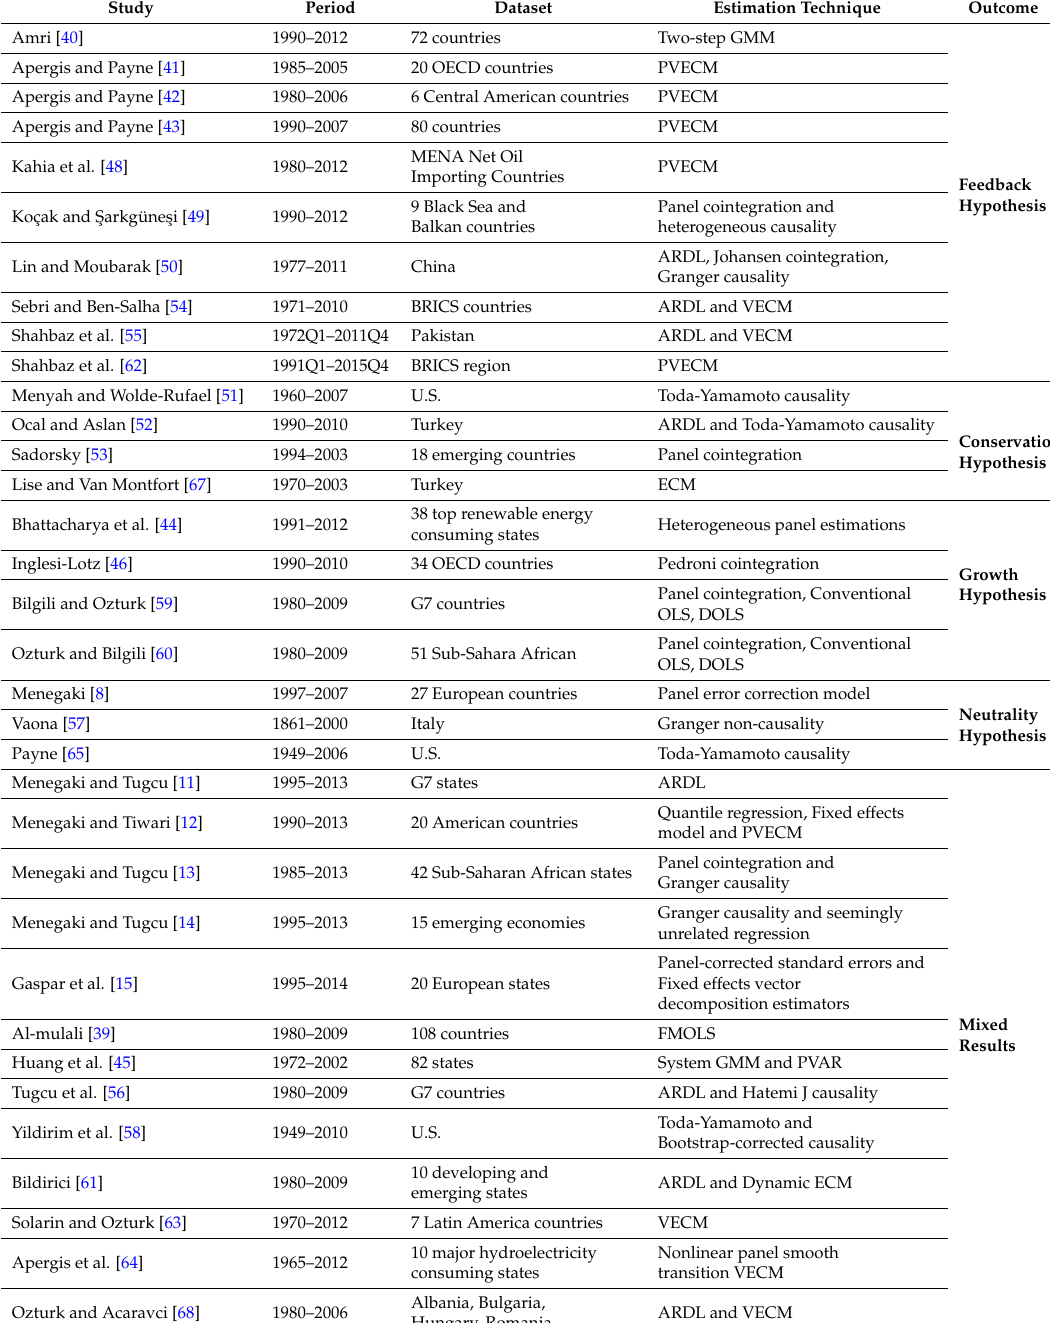
Table 1. Previous related studies on renewable energy consumption and economic